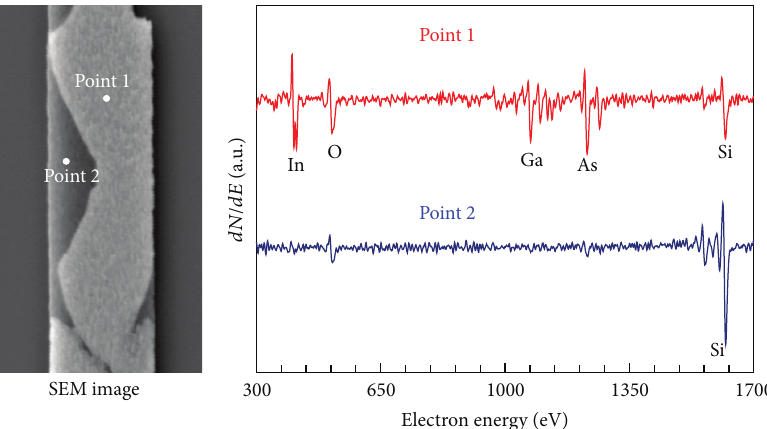
Figure 4: SEM image showing that dark region and bright region coexist in InGaAs stripe after RMG. The data shows the compositions of the two color contrast